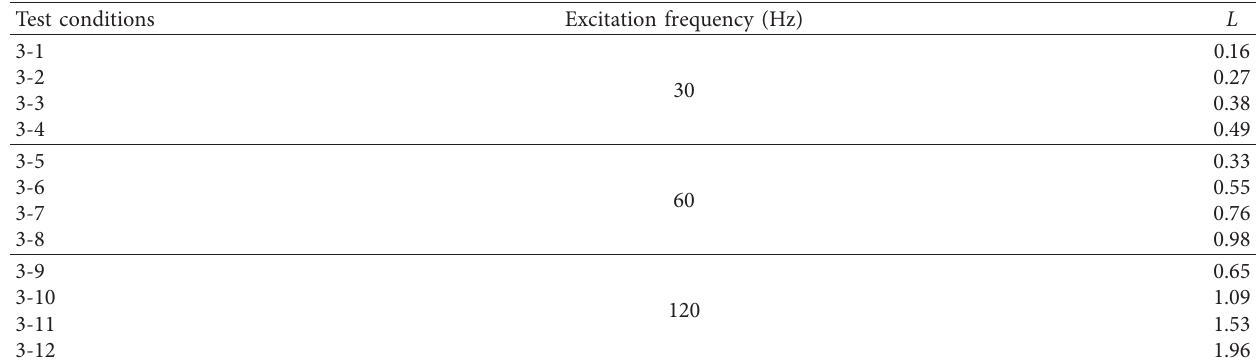
Figure 8: Fitting curve of W and Table 8: Test arrangement for the parameter l .